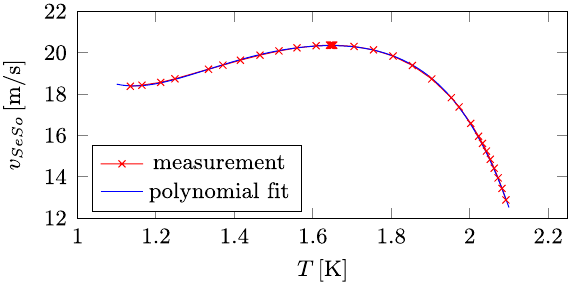
FIG. 3. Second Sound velocity v SeSo versus temperature